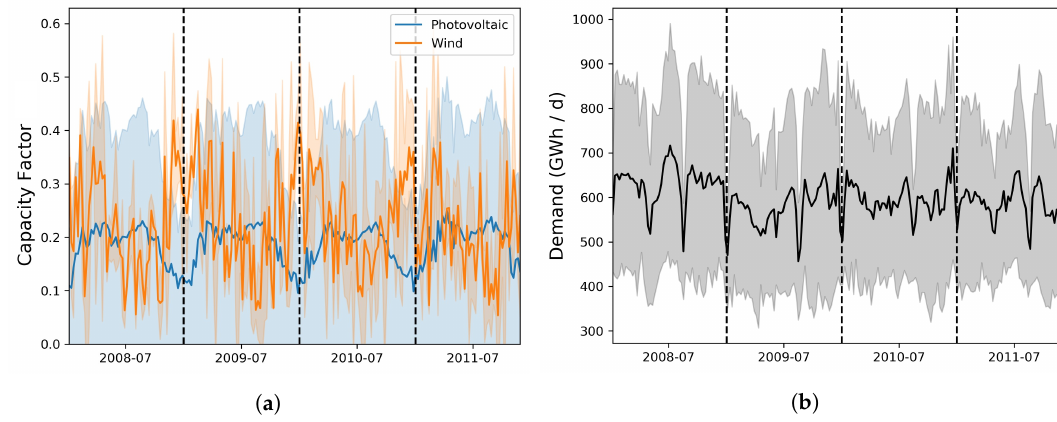
Figure A3. Time evolution of weekly averaged PV (orange) and wind (blue) capacity factors ( a ) and demand ( b ). The shadings represent the standard deviation of the time